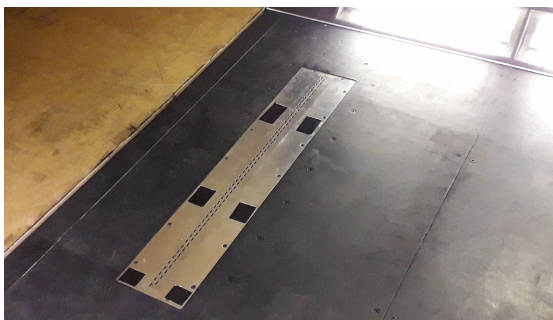
Figure 8. Boundary layer seeder at the start of the working